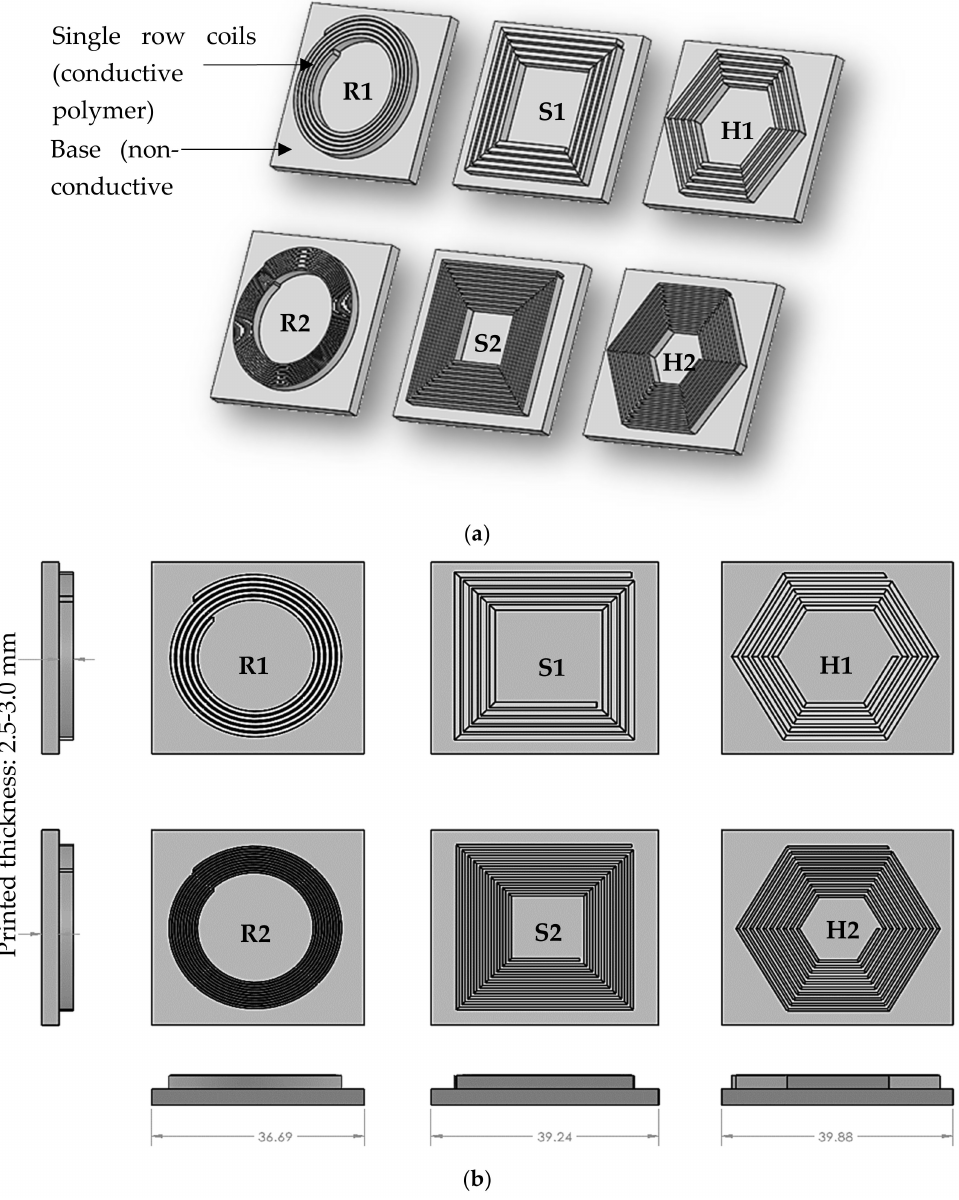
Figure 1. CAD model of the round, square and hexagon coils with thick (1) and thin (2) widths developed for 3D printing in ( a ): 3D and ( b ): top views; R: Round coil, S: Square coil, H: Hexagon